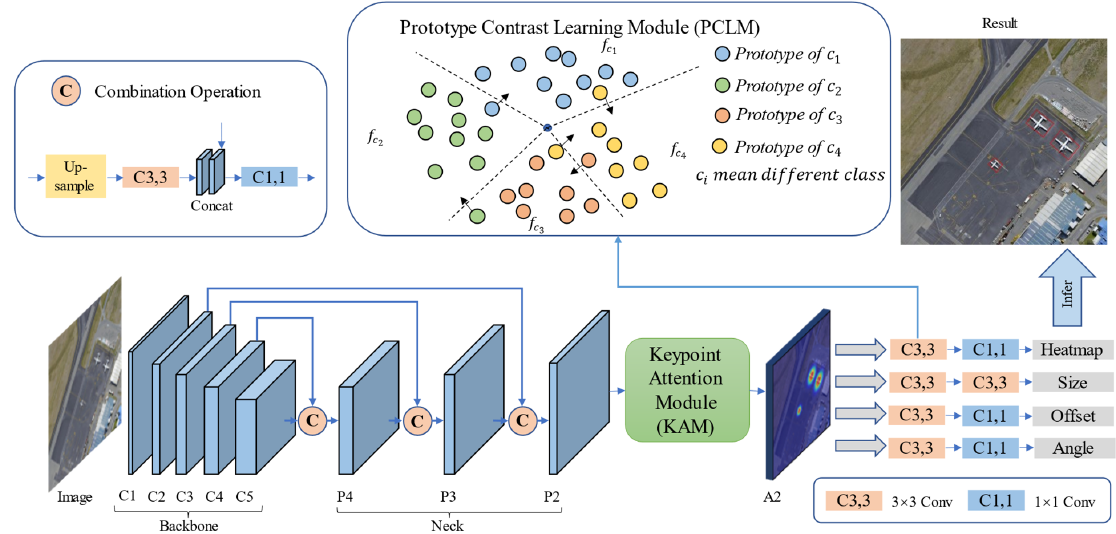
Figure 2. The overall architecture of the O 2 DFFE detection network.